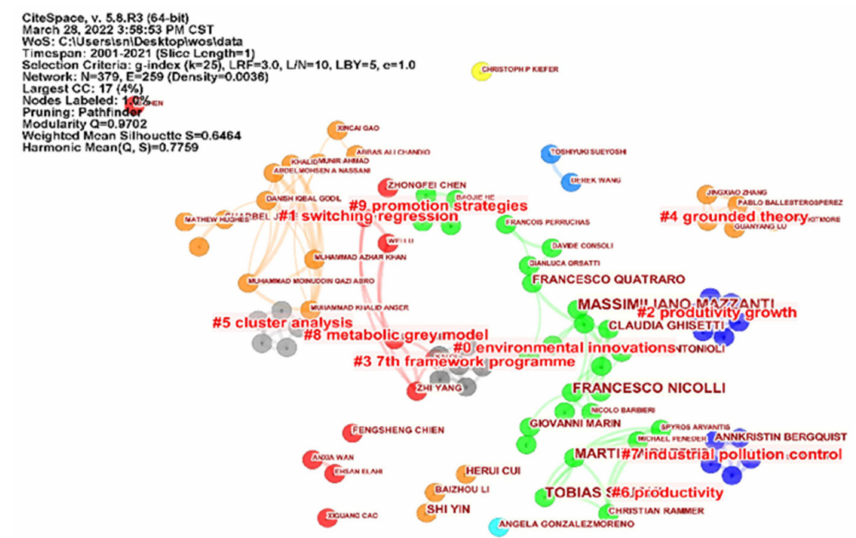
Figure 3. CiteSpace-based author collaboration clustering